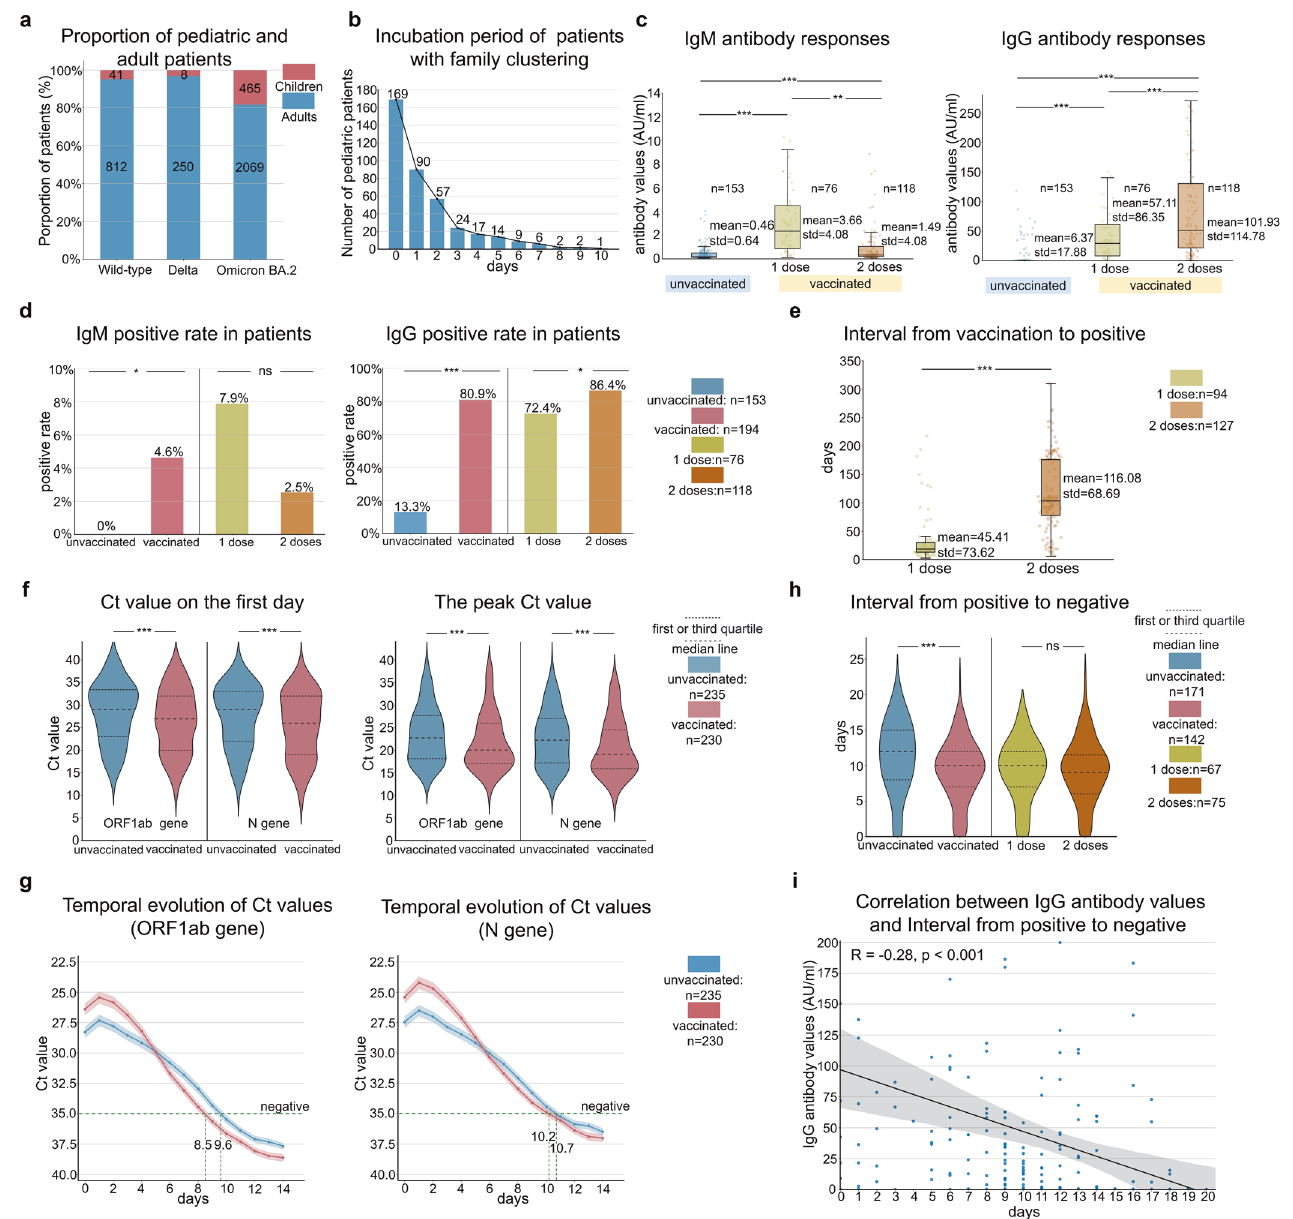
Fig. 1 Characteristics and vaccine effectiveness against SARS-CoV-2 Omicron subvariant BA.2 in the children. a Proportion of pediatric and adult patients for Wild-type, Delta, and Omicron BA.2 strains. The red color represents pediatric patients, the blue color represents adult patients and the numbers in the bar represent the total number of patients in each category. b Incubation period of 391 pediatric patients with family clustering in Omicron BA.2 group. The incubation period is the time interval between the date of symptom onset in children and the date their family members fi rst tested positive. c Antibody responses in the pediatric patients infected with Omicron BA.2. The left panel of c represents IgM antibody values (AU/ml) in vaccinated and unvaccinated patients. The right panel of c represents IgG antibody values (AU/ ml) in vaccinated and unvaccinated patients. ** p < 0.01, *** p < 0.001, Student ’ s t -test. d IgM and IgG positive rates in vaccinated and unvaccinated patients. Patients are IgM or IgG positive if the IgM or IgG antibody value is greater than 10 AU/ml. * p < 0.05, *** p < 0.001, ns indicates no signi fi cance, Student ’ s t -test. e The time interval from the last dose of vaccination to positive in vaccinated patients with 1 dose and 2 doses. *** p < 0.001, Student ’ s t -test. f Ct value (ORF1ab and N genes) in patients. The left panel of f represents Ct value (ORF1ab and N genes) on the fi rst day in vaccinated and unvaccinated patients. The right panel of f represents the peak Ct value (ORF1ab and N genes) in vaccinated and unvaccinated patients. *** p < 0.001, Student ’ s t -test. h The time interval from the positive to negative in vaccinated and unvaccinated patients. *** p < 0.001, ns indicates no signi fi cance, Student ’ s t -test. g The temporal evolution of Ct value (ORF1ab and N genes) of vaccinated and unvaccinated groups. Patients in the unvaccinated and vaccinated groups are selected who turned negative (Ct values of ORF1ab gene and N gene are both greater than 35) and had no subsequent positive return. i Correlation between IgG antibody values and the time for nucleic acid negative conversion (Pearson correlation coef fi cient, R = − 0.28, p < 0.001)